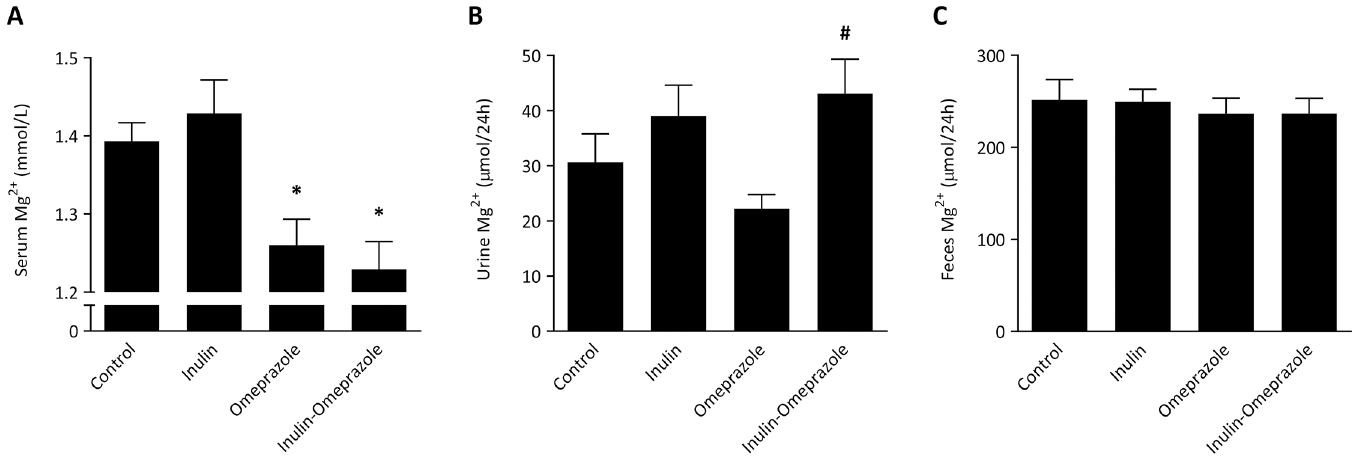
Fig 1. Effects of inulin diets and omeprazole treatment on the Mg 2+ homeostasis of C57BL/6J mice. Serum Mg 2+ concentration (A), 24 h urinary Mg 2+ excretion (B) and 24 h fecal Mg 2+ excretion (C). All values are presented as means ± SEM (n = 10 per group). Significant differences between control vs. both omeprazole groups are indicated by * with P < 0.05, significant differences between the omeprazole-treated groups are annotated by # with P < 0.05.